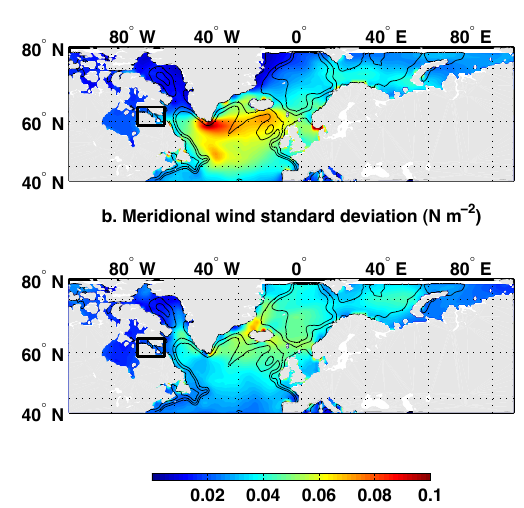
Figure 5. Standard deviations of nonseasonal (a) zonal and (b) meridional wind stress from ERA-Interim used to force the barotropic model. Units are Nm − 2 . Thick black box drawn around Hudson Strait is the control volume for the numerical experiment with altered surface wind stress forcing described in Sect. 3.4. Thin black contours are the model’s 200, 1000, and 2000m isobaths, shown for reference.